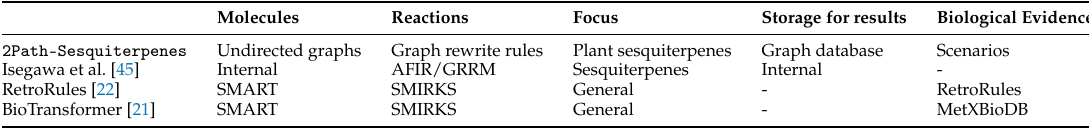
Table 1. A summary of some features of the 2Path-Sesquiterpenes and its related works.